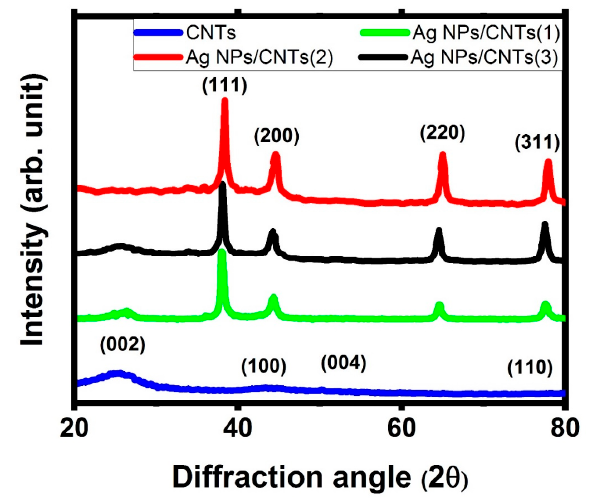
Figure 2. XRD diffractogram of the used CNTs and their decoration by Ag NPs with different concentrations based on tuning laser ablation time. FT-IR and Raman studies were used to investigate the interaction between Ag NPs and functional groups on the outer surface of functionalized CNTs. Figure 3a showed that FT-IR spectra of the utilized CNTs and their nanocomposites with different amounts of Ag nanoparticles clearing that in the case of CNTs, it can be noticed that the existence of adsorption bands at 3433 cm -1 is corresponding to –OH stretching vibration. Also, the main characteristic peak of the functionalized carbon nanotube skeleton structure of CNTs was observed around 1642 cm -1 related to the functional group of C=C bonding of aro- matic rings. The presence of the carbonyl functional group in the carboxylic functional group (-COOH) was detected around 1700 cm -1 , confirming the effect of functionalization on the CNTs’ tubular outer surface. Besides, the presence of the stretching vibrational mo- tion at 920 cm -1 was related to C-O functional group of carboxylic acid. These FT-IR data indicated that the oxidation treatment process was successfully produced on the outer surface of CNTs by adding functional carboxyl and hydroxyl groups [39–42]. In the case of decoration with Ag NPs, the interactions between silver ions and the hydroxyl group of CNTs are responsible for the change in the intensity and in the positions of the peaks in the range from 1400 cm -1 to 1000 cm -1 . Besides, the presence of the vibrating starching modes C-Ag functional group at 594 cm -1 . These data could represent a confirmation on the interaction. [43,44].